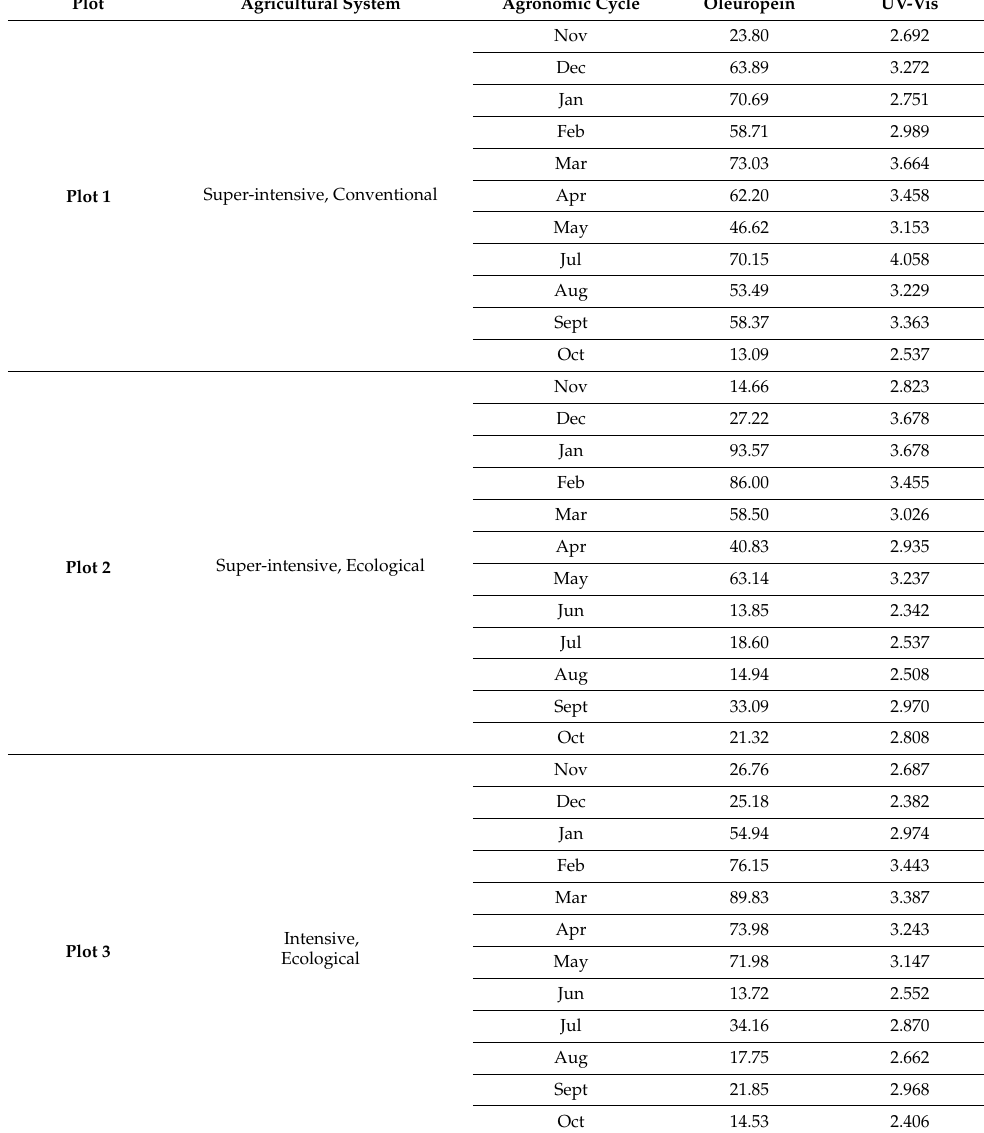
Table A2. Evolution of oleuropein (mg/g) and absorbance at 280 nm of olive leaves cv. Arbequina.